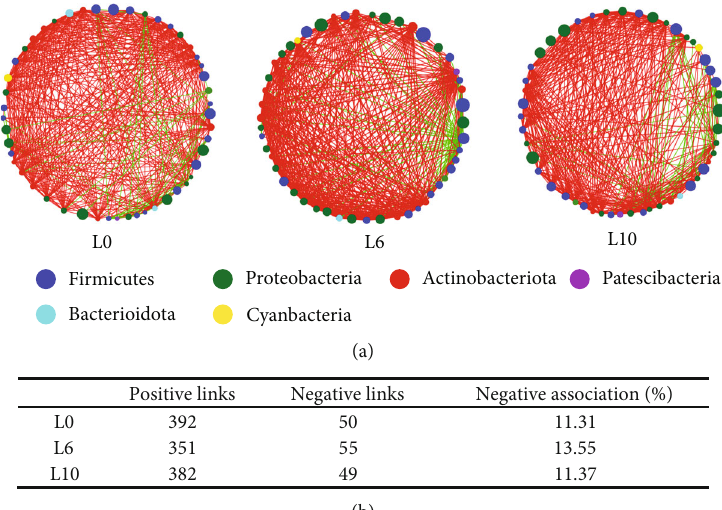
Figure 8: Correlation-based network analysis of the bacterial community in C. quadricarinatus fed diets with di ff erent lipid levels. (a) Each node represents one genus, its colors represent the di ff erent phylum levels of bacteria, and its size was proportional to the number of connections (degree). The green edge indicates a negative interaction between two individual nodes. The red edge indicates a positive interaction between two individual nodes. (b) Interspecies interaction types and the ratio of negative interactions in the ecological